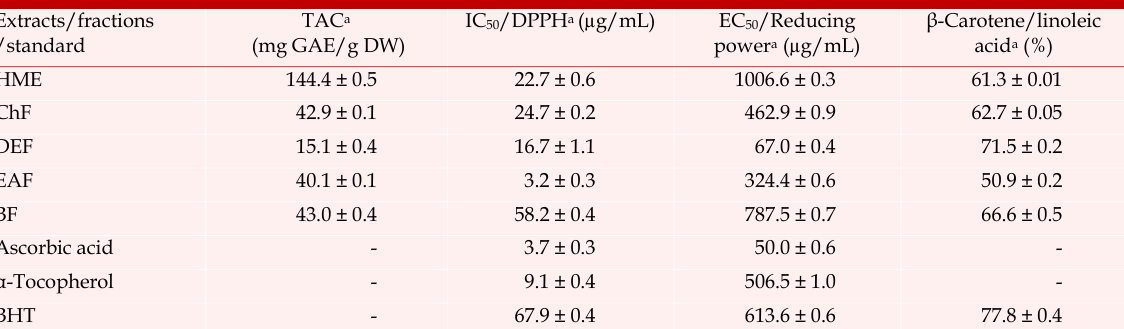
Anti-oxidant capacities of extracts from P. coulteri and standards measured by different assays Extracts/fractions